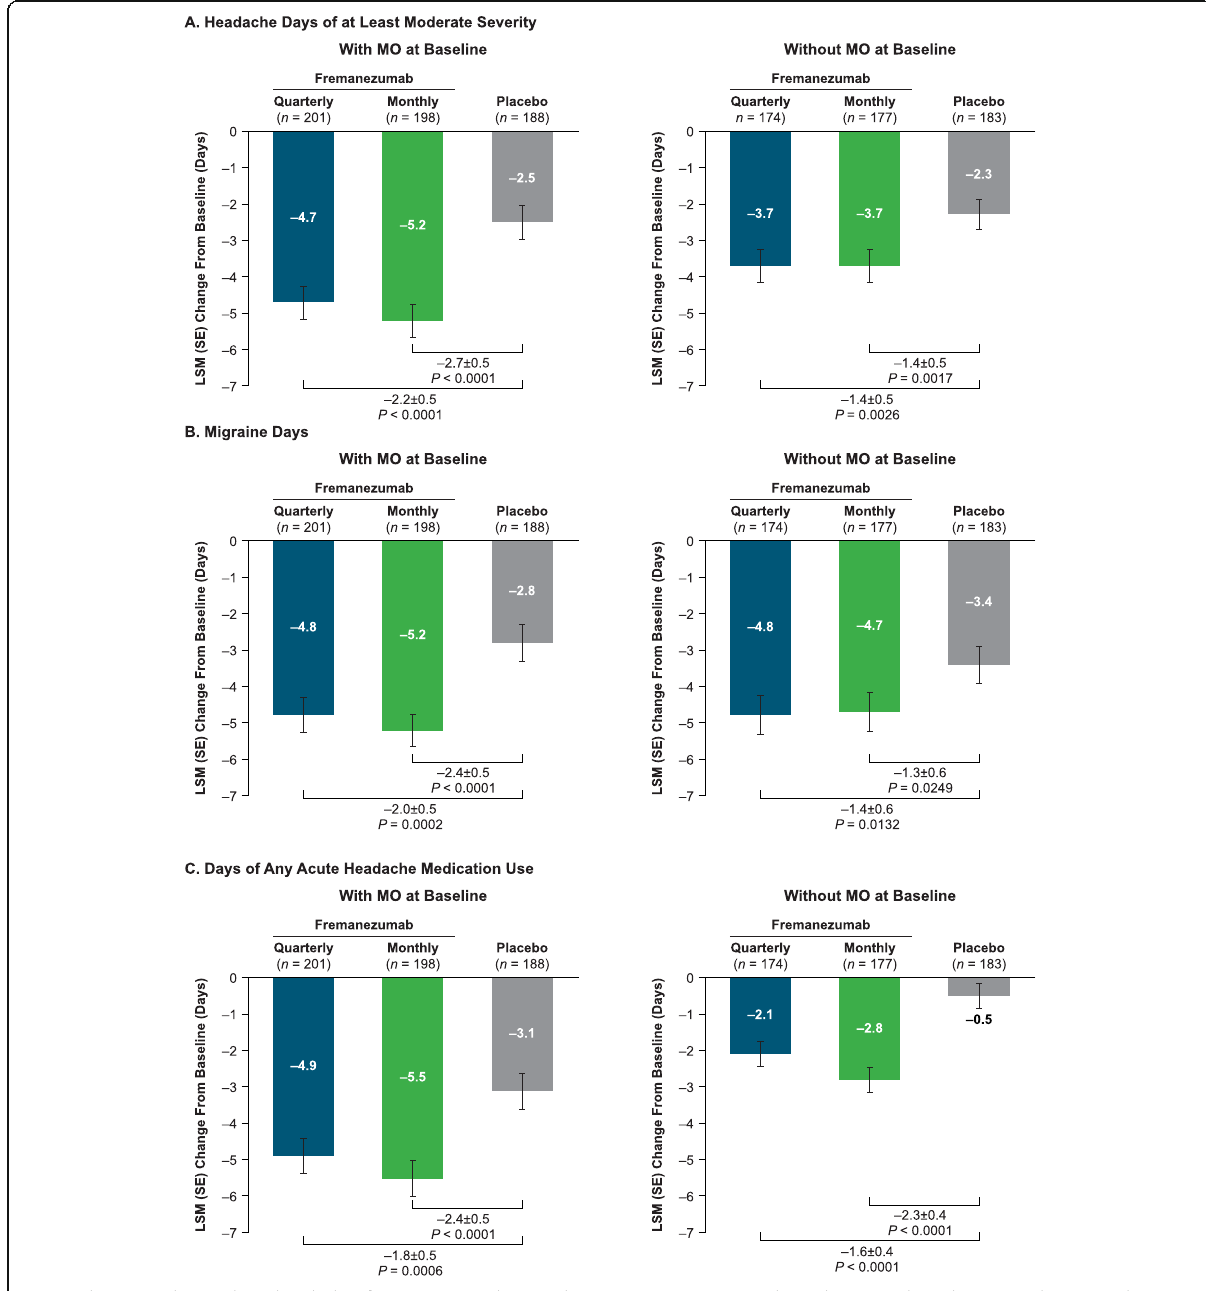
Fig. 1 Change in days with ( a ) headache, ( b ) migraine, and ( c ) medication use in patients with CM by MO. Values shown are the mean changes from baseline in the monthly average number of ( a ) headache days of at least moderate severity, ( b ) migraine days, and ( c ) acute headache medication use during the 12-week treatment period with and without MO. CM, chronic migraine; LSM, least-squares mean; MO, medication overuse; SE, standard